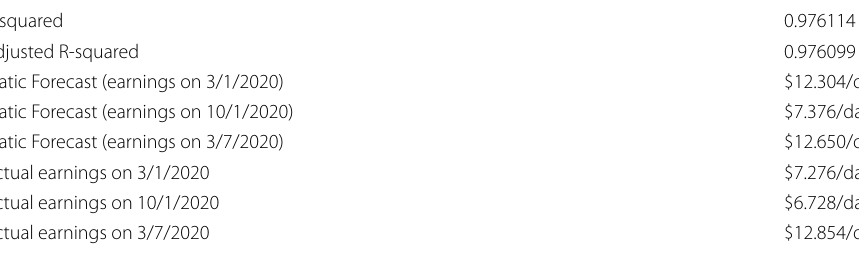
Table 11 Average earnings c. 2010. Source : Elaboration by the authors R-squared Adjusted